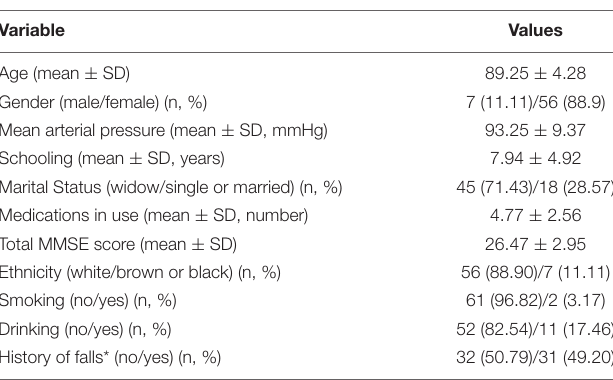
TABLE 1 | Sociodemographic and clinical characteristics of the studied sample ( n =